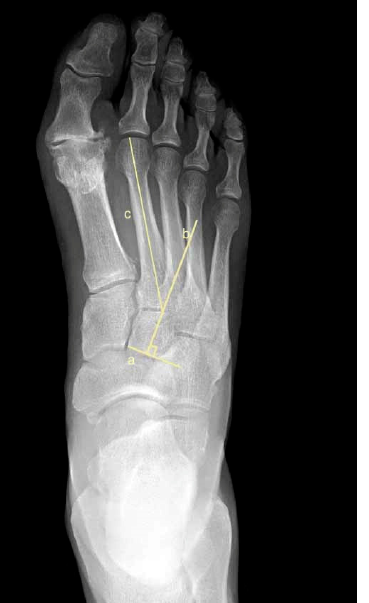
Figure 6. Dorsoplantar weightbearing radiograph of modified Engel’s angle.